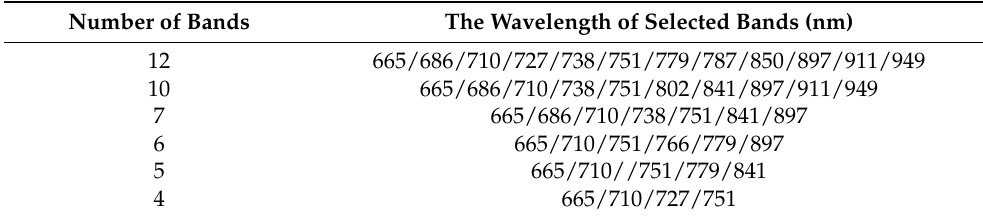
Table 2. Subsets of bands in the first three urban scenarios.